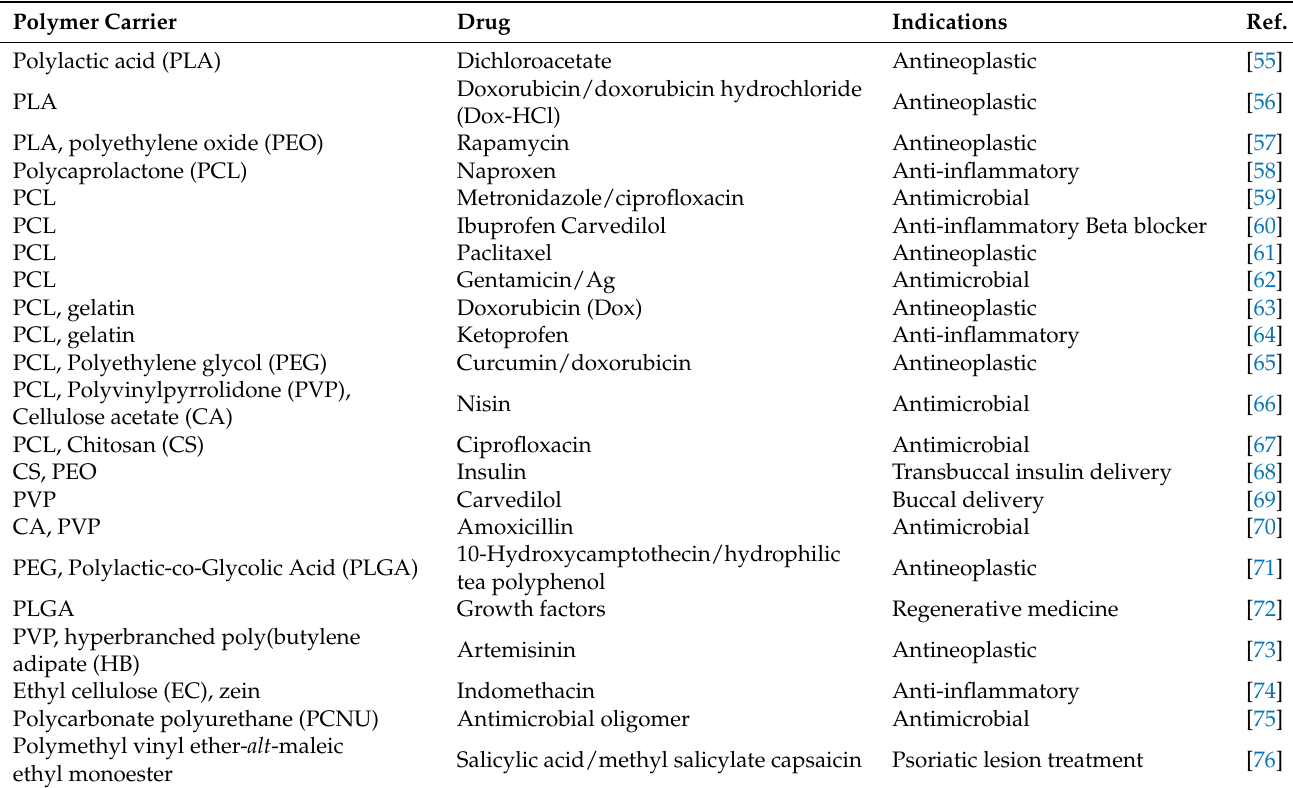
Table 2. Exemplar drug delivery applications of electrospun